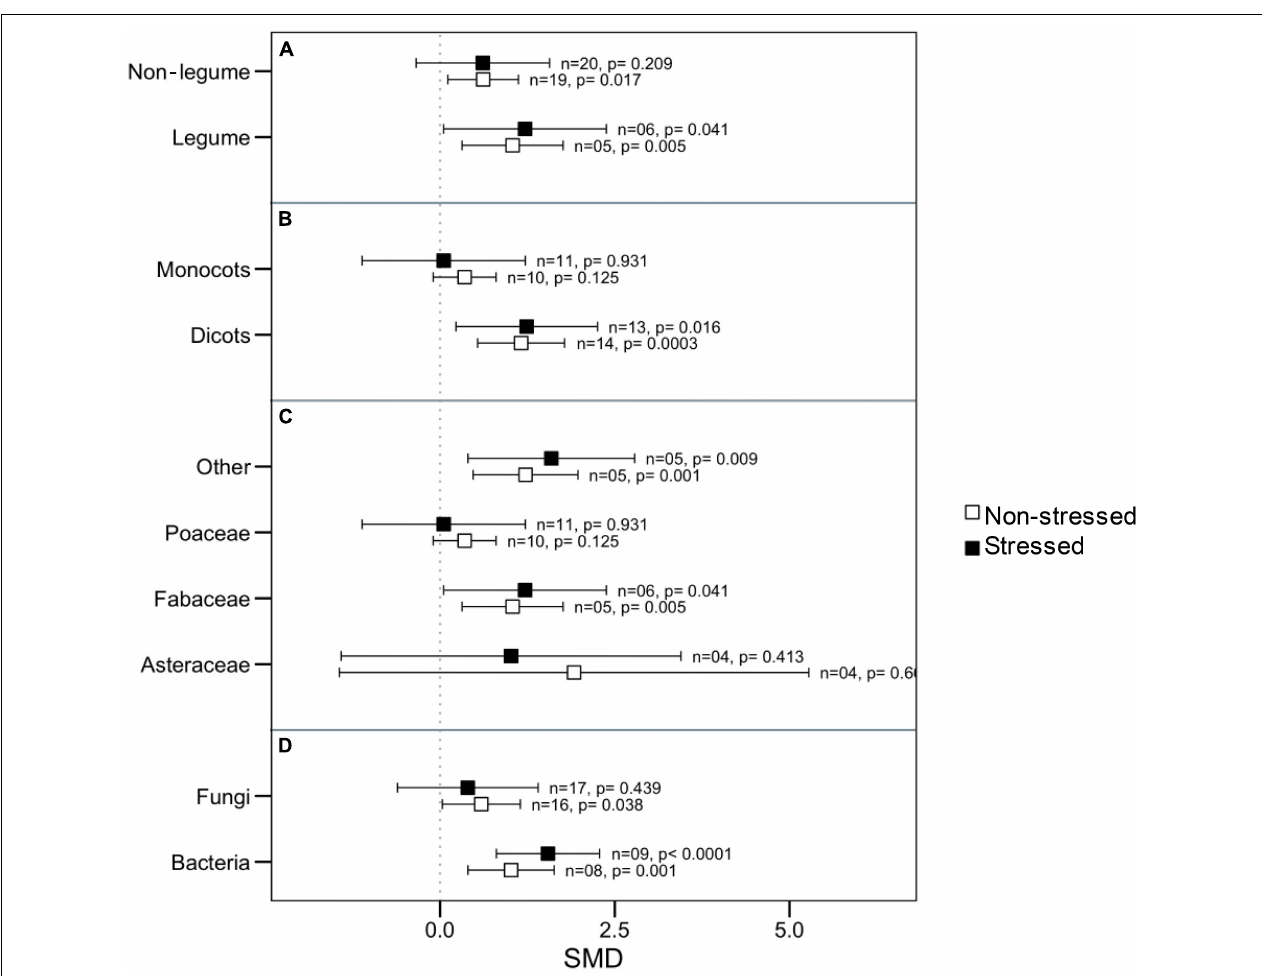
FIGURE 3 | Effects of microbial inoculation on plant root length under normal and high temperature stress conditions for various categorical variables such as (A) Plant nodulation, (B) Plant clade, (C) Plant Family, and (D) microbes’ types (fungi or bacteria). Error bars are the effect size means ± 95% CIs. Where the CIs do not overlap the vertical dashed lines, the effect size for a parameter is significant, i.e., the growth responses of AMF plants were significantly different from those of non-AMF plants. n = number of studies included in the meta-analysis, p = significance level of